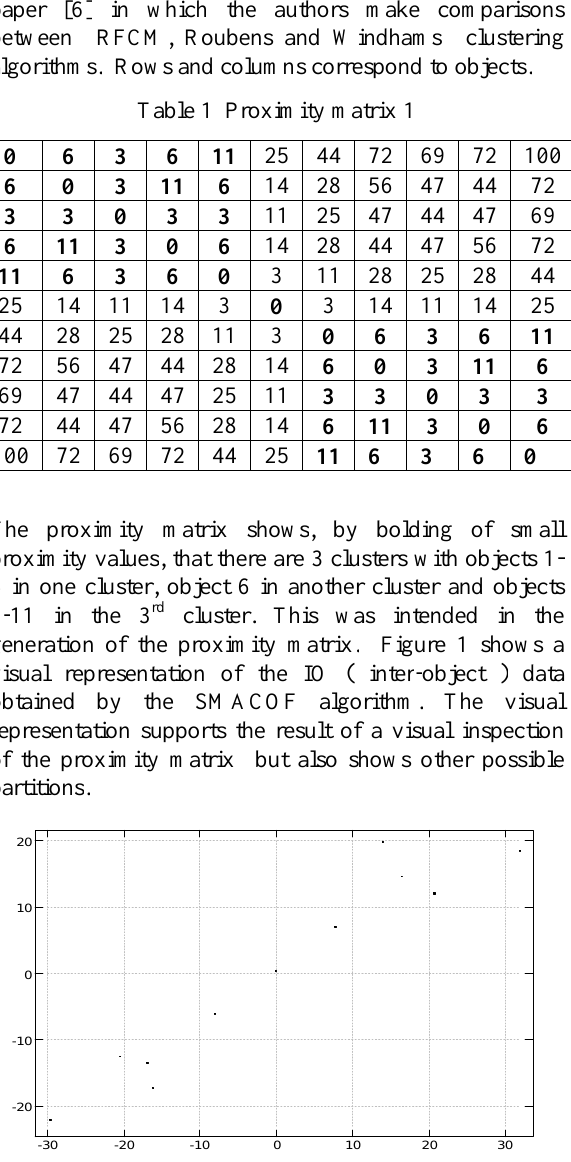
Figure 1 Representation of proximity matrix1 in 2-D The visual representation shows that there are 7 clusters of sizes 1,3,1,1,1,3,1 or 5 clusters with sizes 4,1,1,1,4 or 3 clusters with sizes 4,3,4 or 3 clusters with sizes 5,1,5. If two clusters are permitted than one object belongs equally in both. The membership matrices in Table 2 for 2 clusters should bear this out. Bolded values are maximum values. Rows correspond to objects and columns correspond to